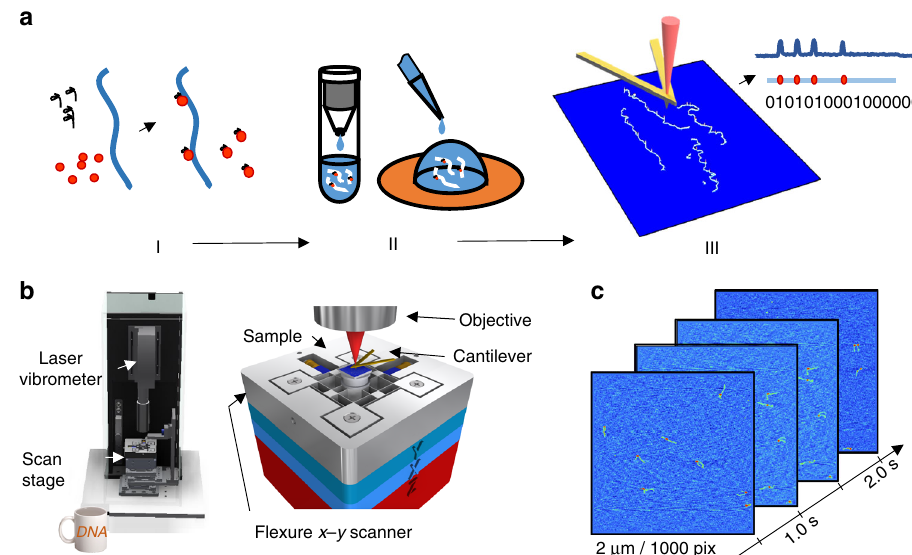
Fig. 1 High-speed AFM measurement of Cas9-labeled DNA. a Cas9 labeling chemistry and sample preparation work fl ow: (I) incubate target DNA with Cas9 – sgRNA and fi x with formaldehyde, (II) remove unbound Cas9 – sgRNA complexes and deposit molecules on mica, and (III) image with HS-AFM and measure locations of labels on DNA. b High-speed contact mode AFM, with a coffee mug for scale. The zoom-in view of the x – y fl exure scanner shows the relative positions of the sample, cantilever, and laser vibrometer objective. c As con fi gured, the HS-AFM produces two 16-bit, 1000 × 1000 pixel